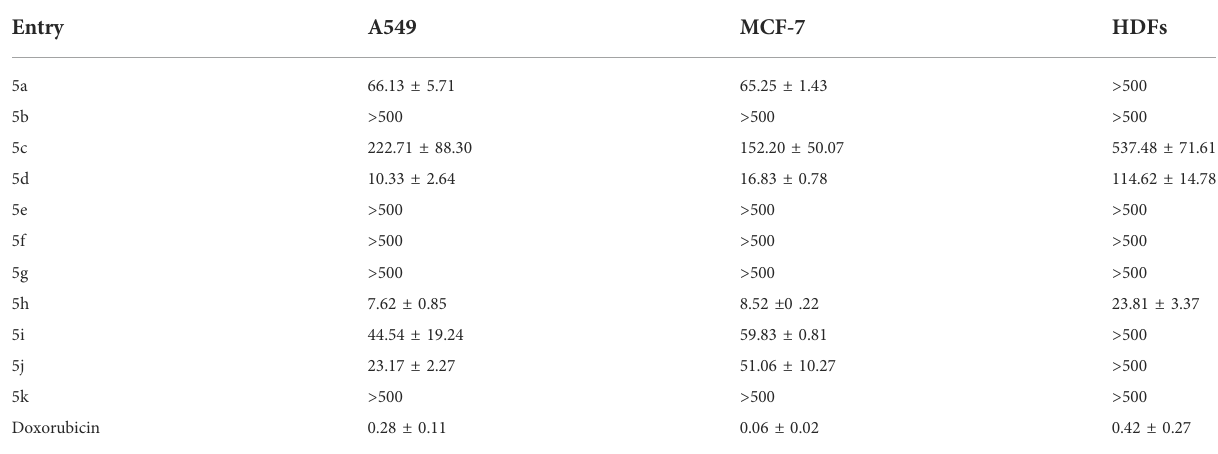
* IC 50 values ware expressed as the average ±SD of four independent experiments